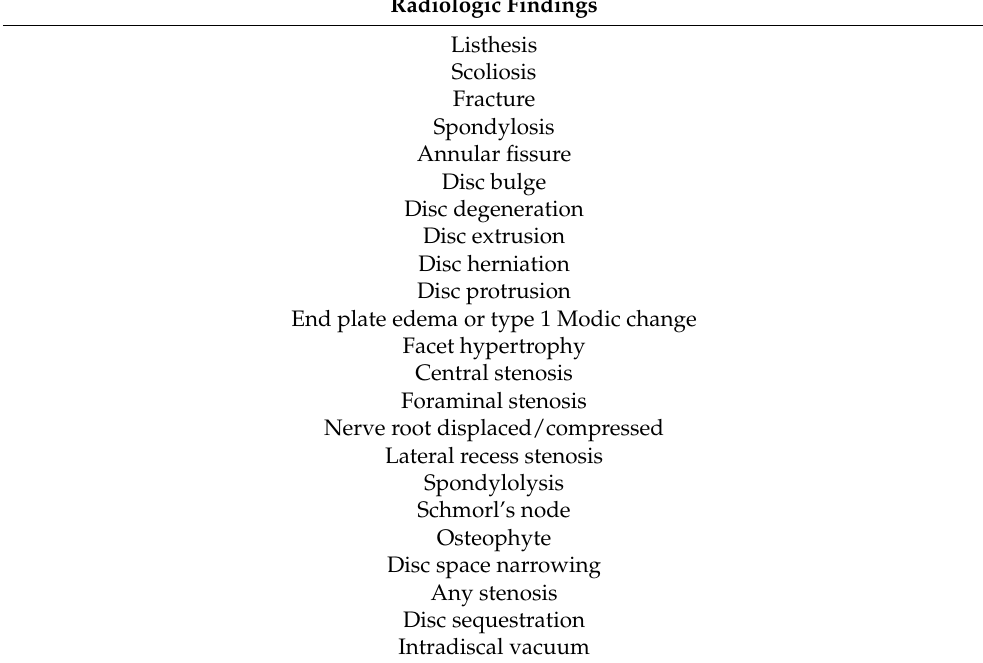
Table 1. 23 Radiologic findings of the